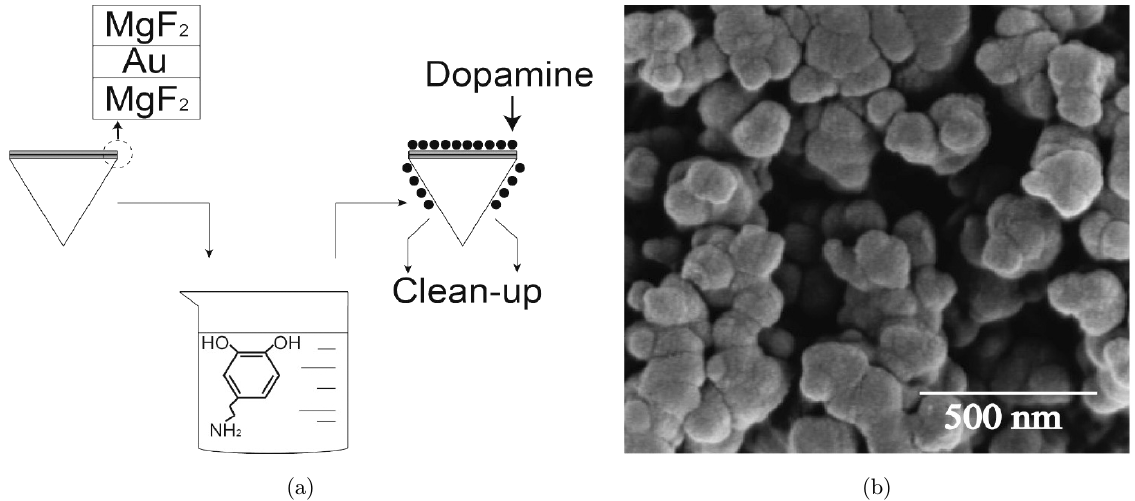
Fig. 1. (a) Structure of our SPR sensor chip and process of dopamine modi¯cation. (b) The surface morphology of polydopamine